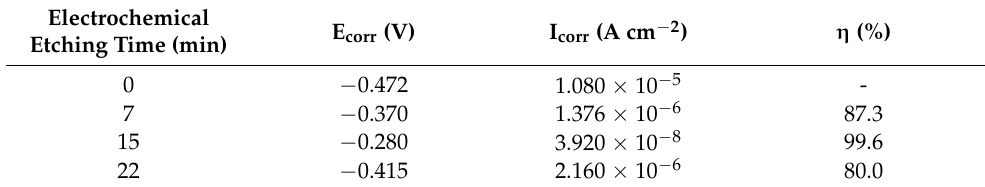
Figure 4. ( a ) Polarisation curves of samples in different corrosion times in 3.5 w.t.% NaCl solution; ( b ) Nyquist plots of the original sample and the superhydrophobic sample in a 3.5 wt.% NaCl solution; ( c ) bode plots of the impedance spectrum of the original sample and the superhydrophobic sample in a 3.5 wt.% NaCl solution; ( d ) equivalent circuit diagram. Table 2. Corrosion potential and corrosion current density of samples with different electrochemical etching